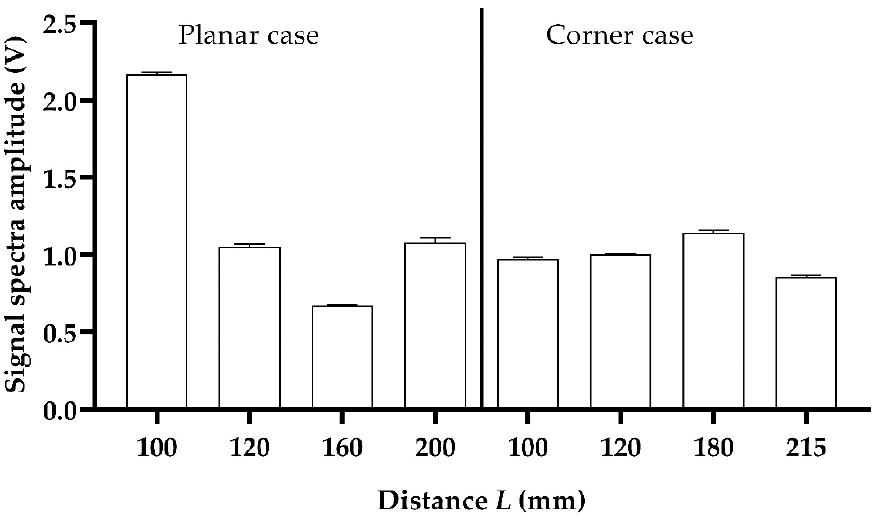
Figure 4. Statistical evaluation of signal spectra amplitudes from signal frequency decomposition.